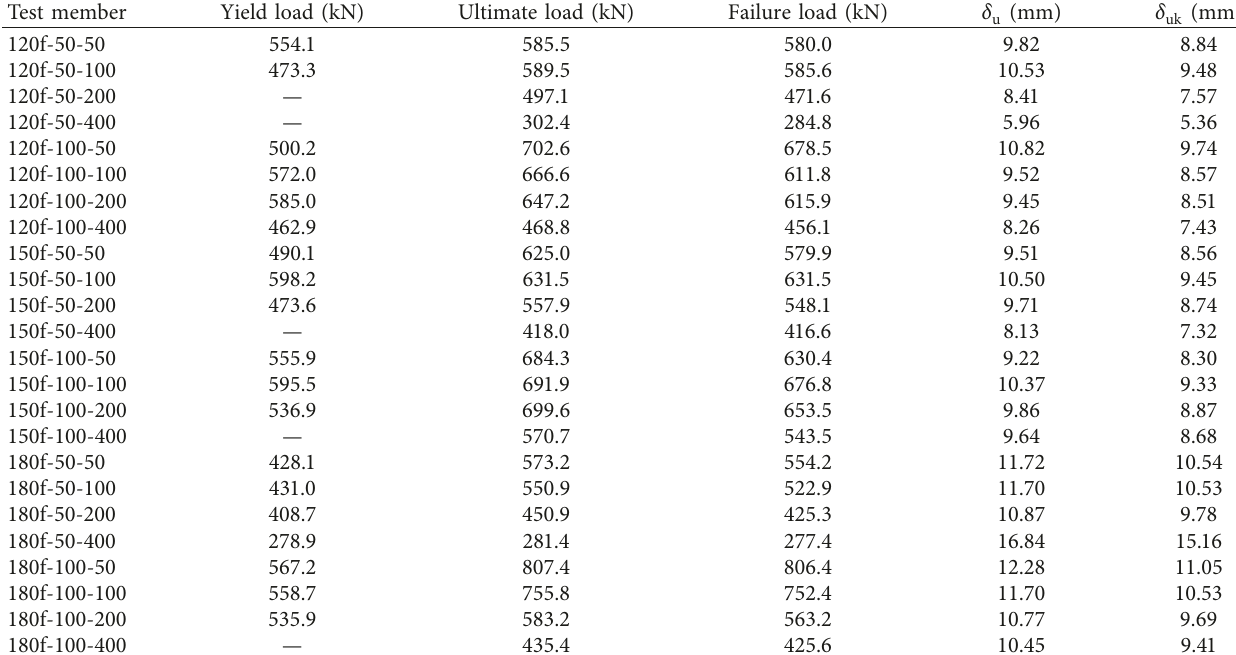
Figure 6: Load-displacement curves for the specimens. (a) Slab thickness, stud spacing (50mm, 50mm); (b) slab thickness, stud spacing (100mm, 50mm); (c) slab thickness, stud spacing (50mm, 100mm); (d) slab thickness, stud spacing (100 mm, 100mm); (e) slab thickness, stud spacing (50 mm, 200 mm); (f) slab thickness, stud spacing (100mm, 200mm); (g) slab thickness, stud spacing (50 mm, 400 mm); (h) slab thickness, stud spacing (100mm, 400 mm). Table 4: Yield, ultimate and failure load, and characteristic slip measured in the loading